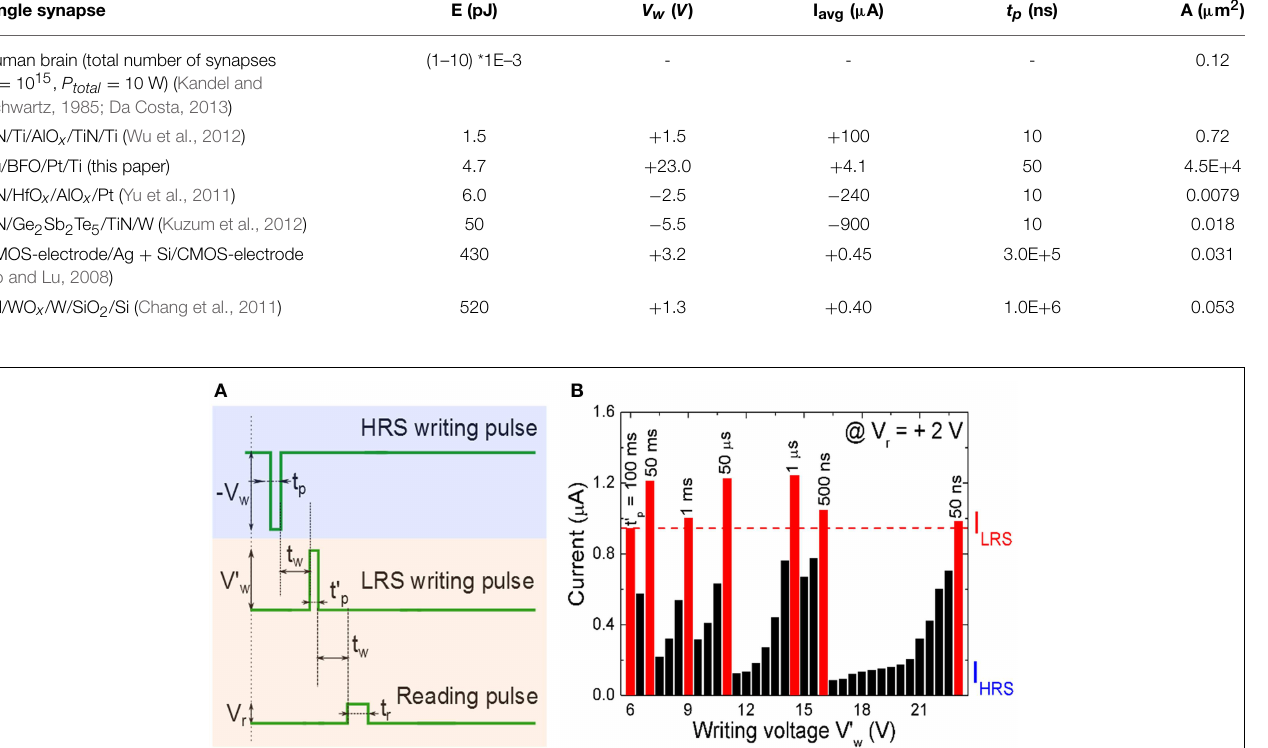
TABLE 2 | Energy consumption E, setting potential amplitude V w , average setting current I avg , pulse width t p and top electrode area size A of resistive switching during SET operation of different memristor-based artificial synapses (Kandel and Schwartz, 1985; Jo et al., 2010; Chang et al., 2011; Yu et al., 2011; Kuzum et al., 2012; Wu et al., 2012).